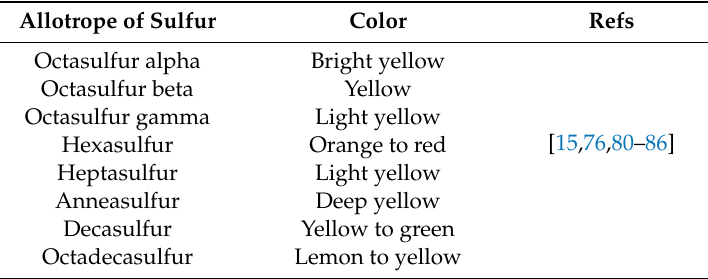
Table 3. Colors of various allotropes of sulfur.